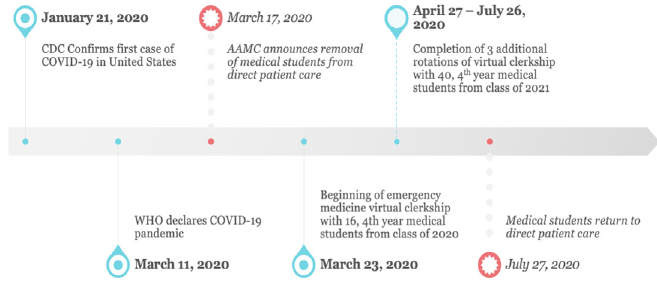
Figure 1. Timeline of the development and implementation of a virtual emergency medicine clerkship during the COVID-19 pandemic.